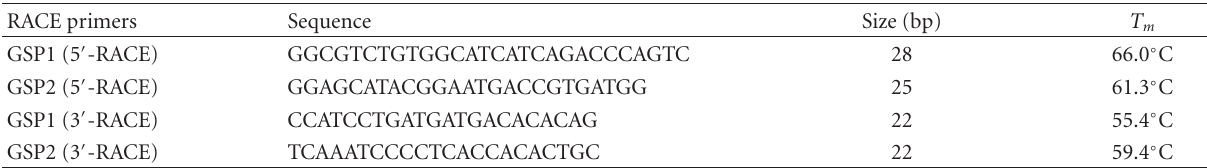
Table 1: The gene-specific primers (GSP) designed for RACE PCR for clone MRSW-40. RACE primers